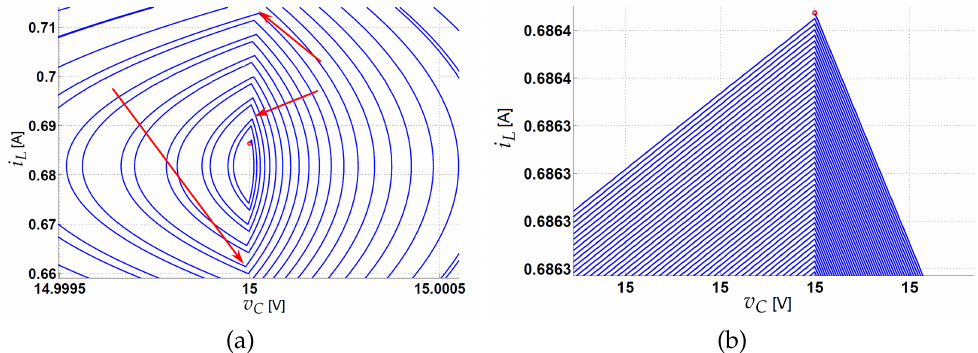
Figure 5. Application of the numerical method to solve an accuracy error on switching boundary: ( a ) state trajectory without the numerical algorithm and ( b ) state trajectory with the numerical algorithm.